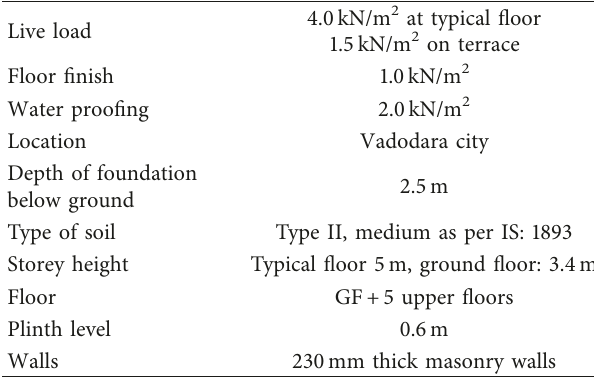
Figure 1: Model of the six-storied building, 3D view. Table 1: Design